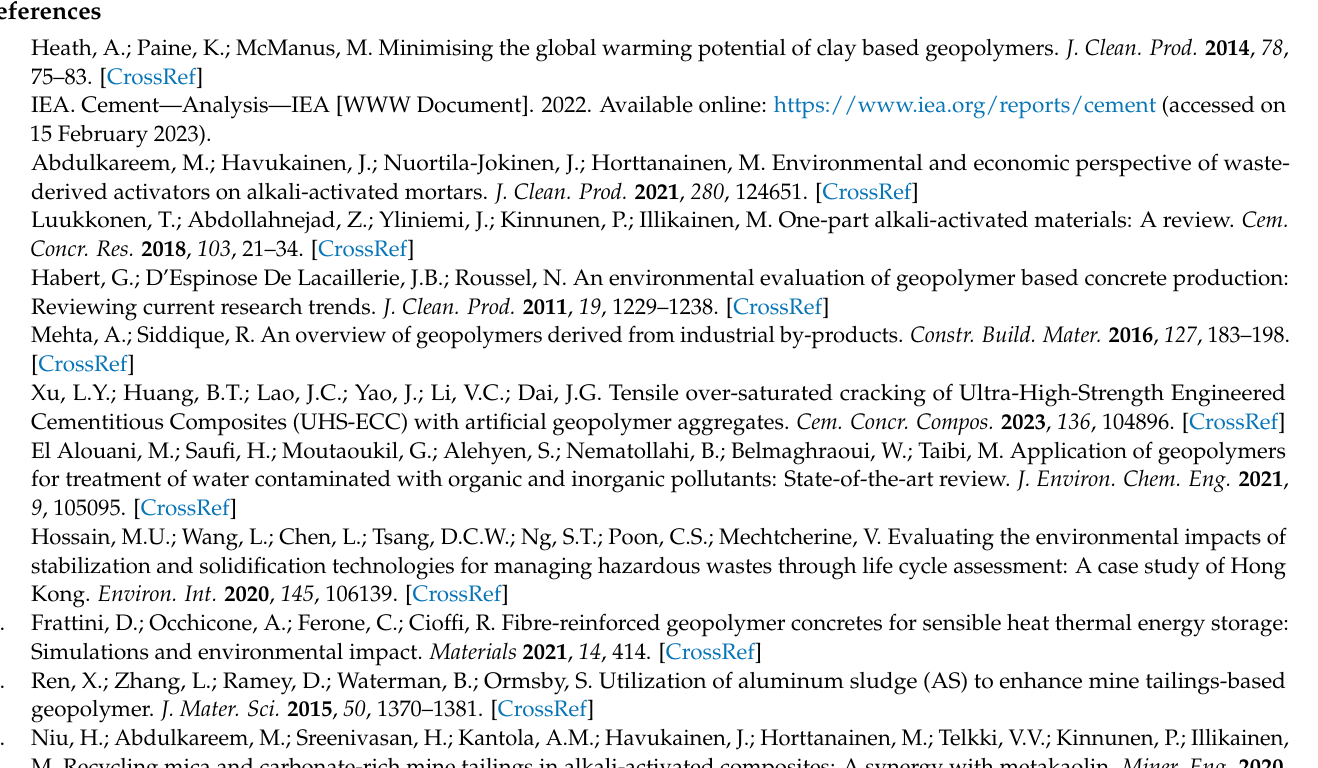
Table S2. Electricity costs; Table S3. Weighted Environmental impacts of precursors & transportation, estimated using Gabi software; Table S4. Transportation distances in km; Table S5. Procurement and transportation costs and landfill costs in Finland; Table S6. Procurement and transportation costs and landfill costs in Belgium; Table S7. Availability of materials in Finland; Table S8. Availability of materials in Belgium; Table S9. Results of linear regression analyses. References [1,14,47,52–76] are cited in the supplementary